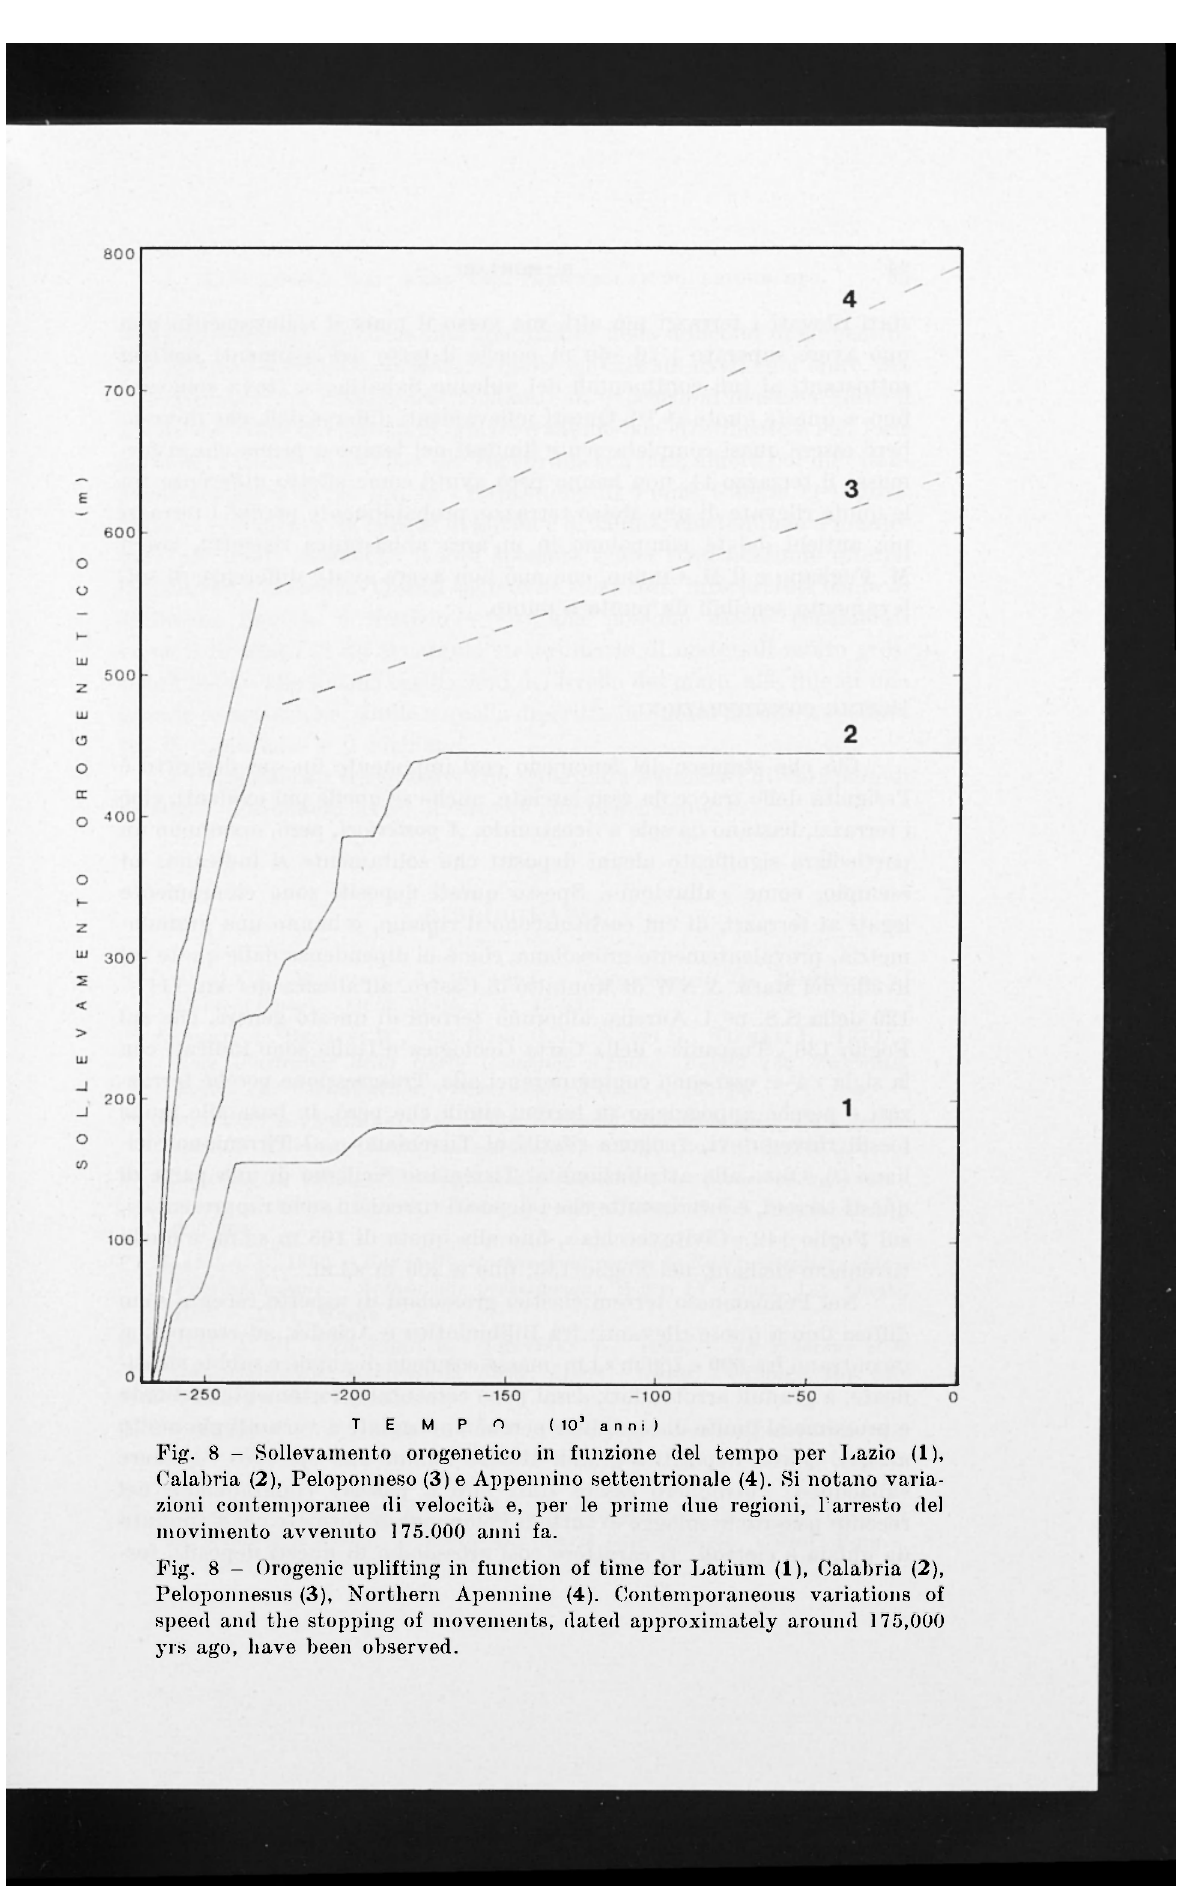
Calabria (2), Peloponneso (3) e Appennino settentrionale (4). Si notano varia- zioni contemporanee di velocità e, per le prime due regioni, l'arresto del movimento avvenuto 175.000 anni fa. Fig. 8 — Orogenic uplifting in function of time for Latium (1), Calabria (2), Peloponnesus (3), Northern Apennine (4). Contemporaneous variations of speed and the stopping of movements, dated approximately around 175,000 yrs ago, have been